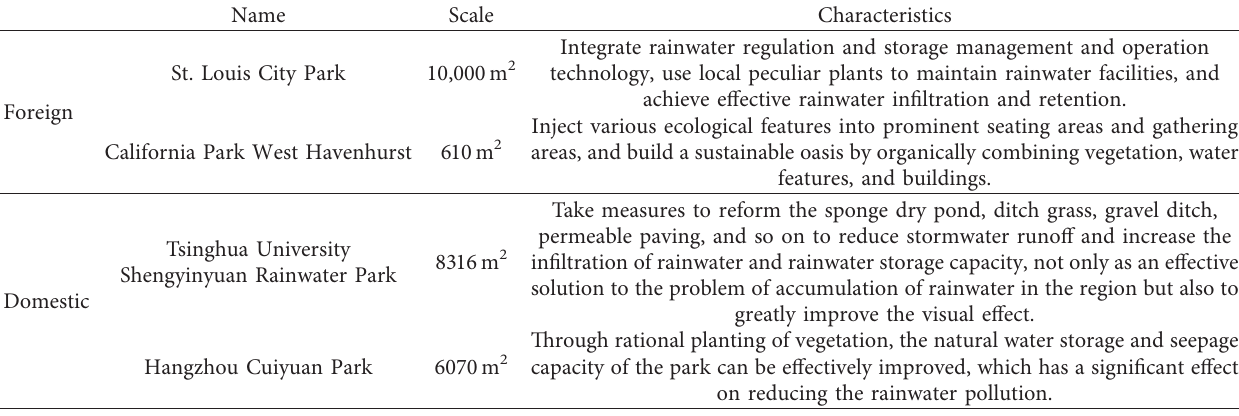
Table 1: Analysis of specific cases of sponge renovation in pocket parks.